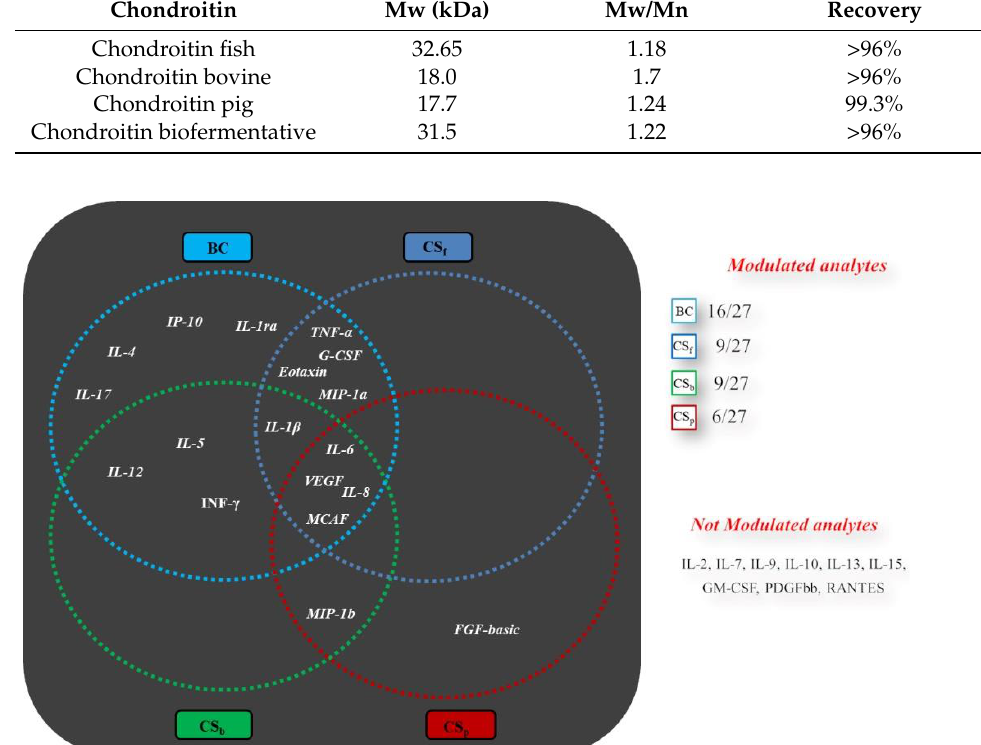
Table 1. Hydrodynamic characterization of chondroitins through Size Exclusion Chromatography coupled to triple array detector (SEC-TDA), molecular weight, polydispersity and purity evaluation. Chondroitin